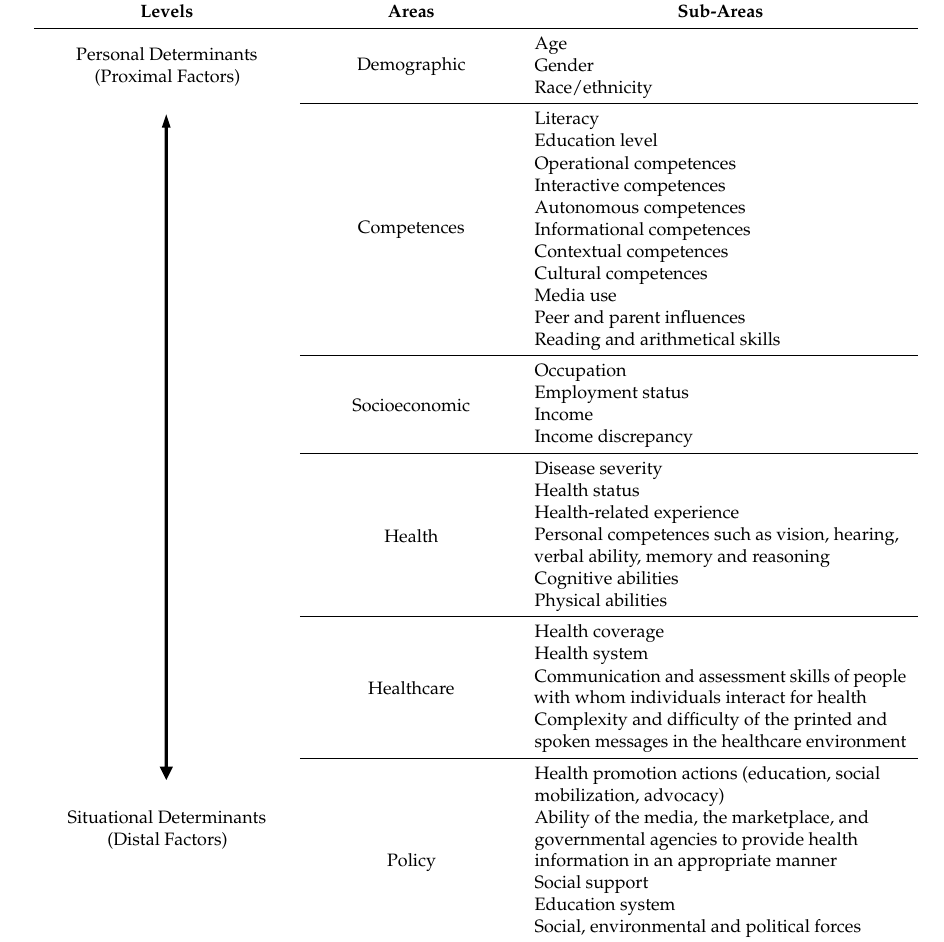
Table 2. Conceptual models of the areas for antecedents (A) and consequences (B) of health literacy, developed from the results of Sørensen’s review [5].